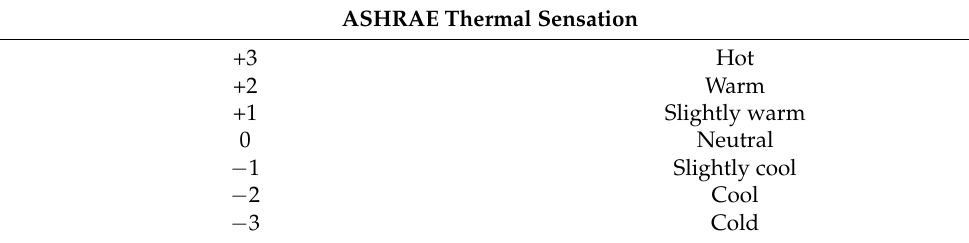
Table 1. ASHRAE seven-point thermal sensation